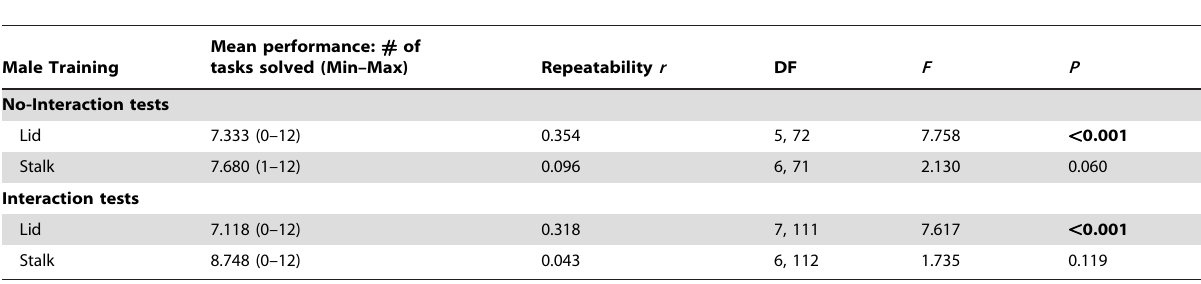
Table 4. Repeatabilities ( r ) of male task